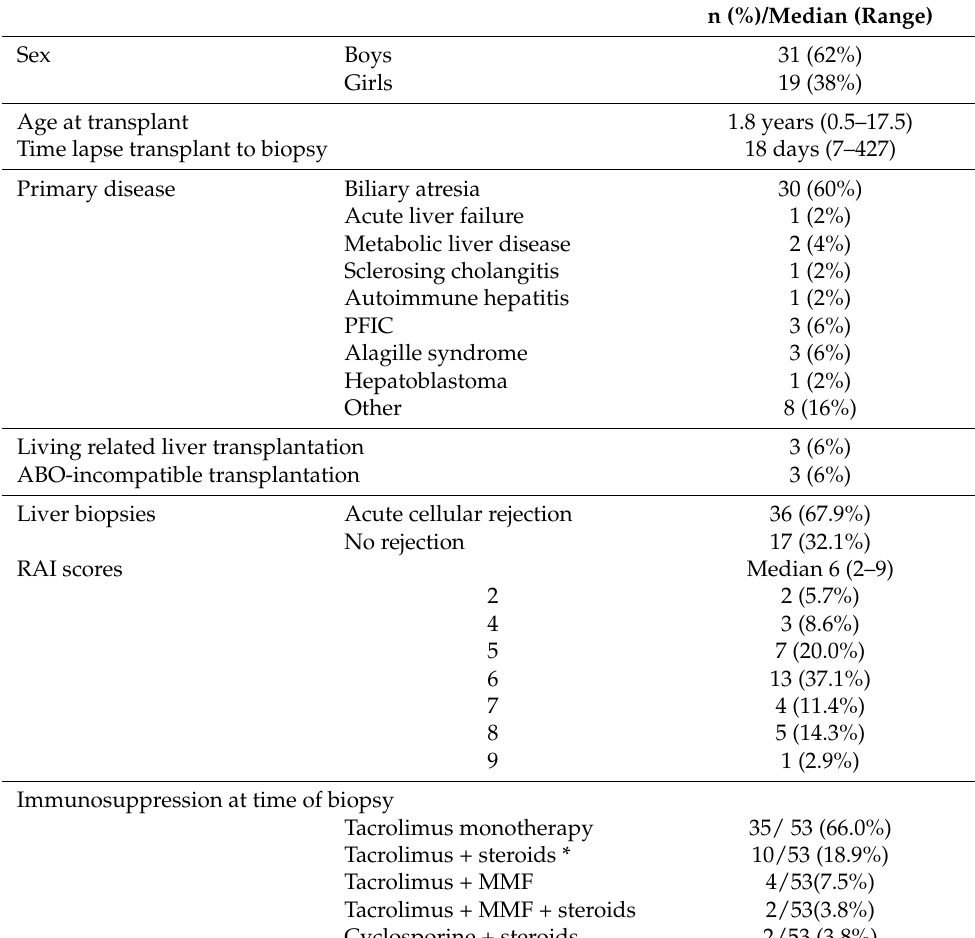
Table 1. Demographic data of the study